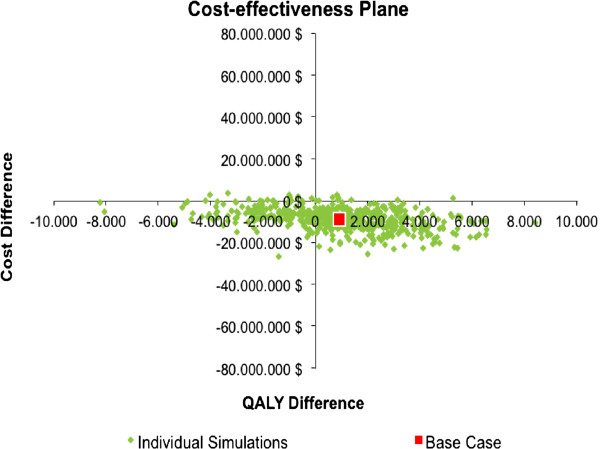
Probabilistic sensitivity analysis. Monte Carlo simulation of 1,000 simulations.